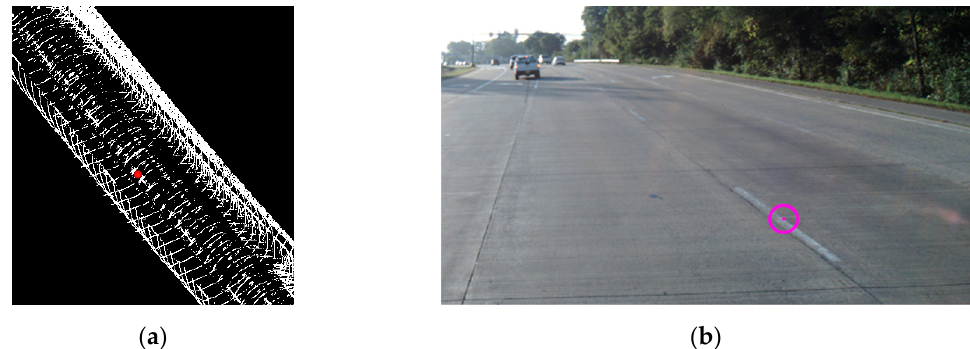
Figure 6. Illustrations of ( a ) hypothesized lane markings extracted by simple thresholding of the original intensity values and ( b ) the corresponding RGB imagery in concrete pavement area.